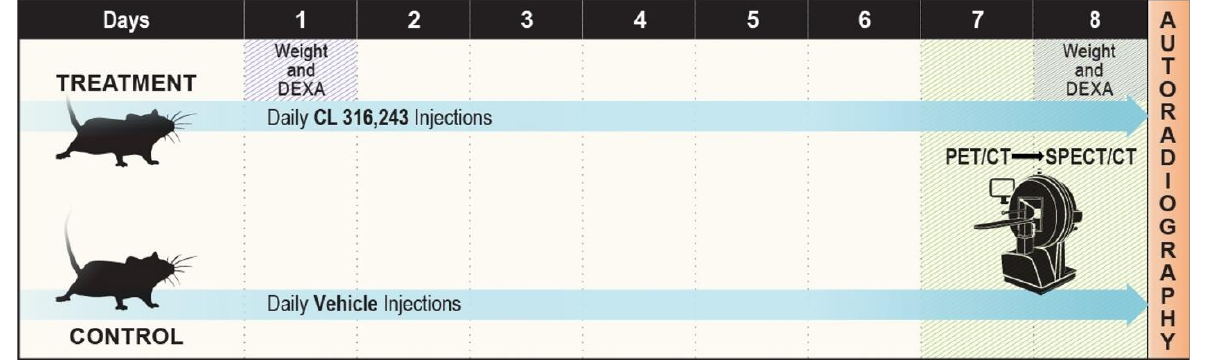
Figure 6. Imaging study protocol schematic. Mice were randomized to treatment with CL-316,243 or vehicle control injections with normal saline. Dual energy X-ray absorptiometry (DEXA) was performed on Days one and eight to assess body fat composition. 18 FDG-PET/CT was performed on Day seven and BMIPP-SPECT/CT on Day eight. Animals were sacrificed after SPECT/CT for auto- radiography.